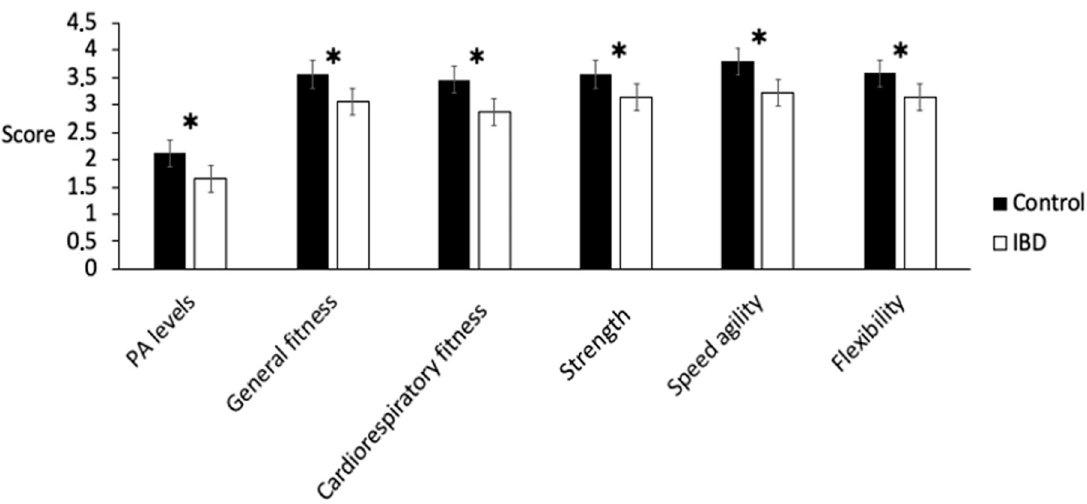
Figure 1. Physical activity levels and physical competences in patients affected by IBD (white col ‐ umns) and in controls (black columns). Note: * p < 0.05. columns) and in controls (black columns). Note: * p <